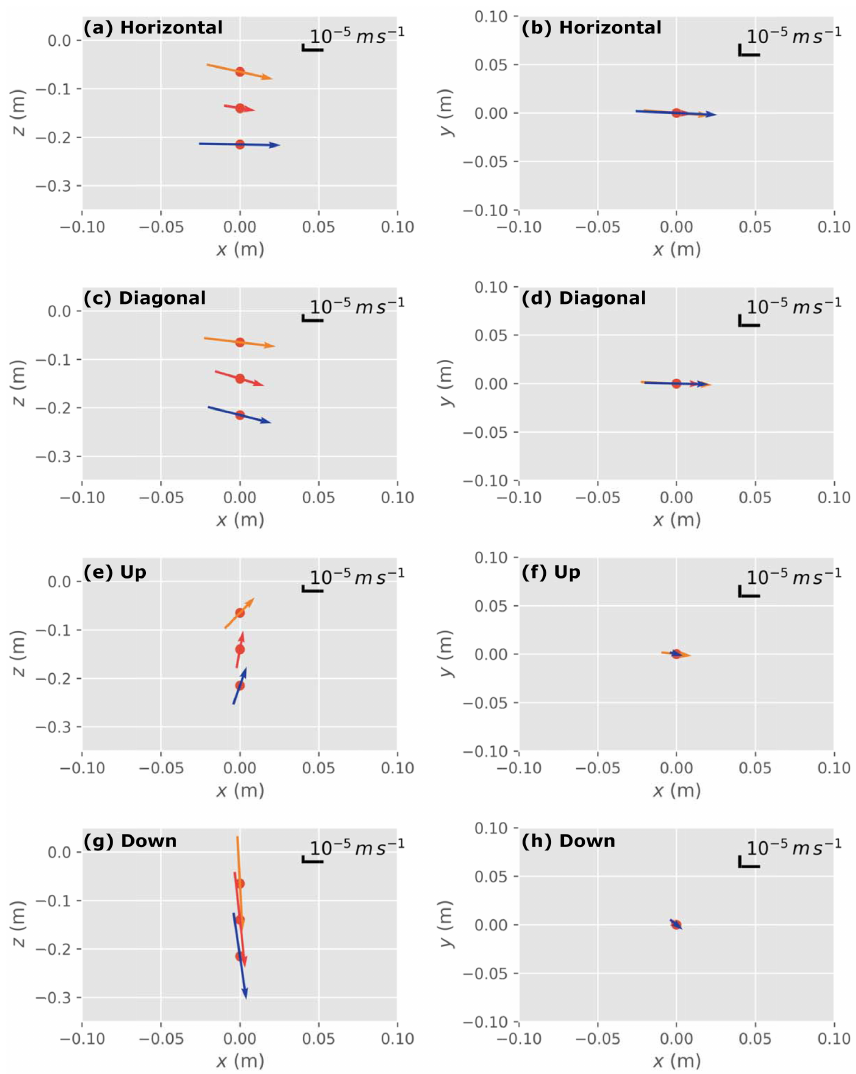
Figure 5. Calculated fluxes and directions for the four flow scenarios at each of the heat injection depths: (a, b) horizontal, (c, d) diagonal, (e, f) upward and (g, h) downward flow